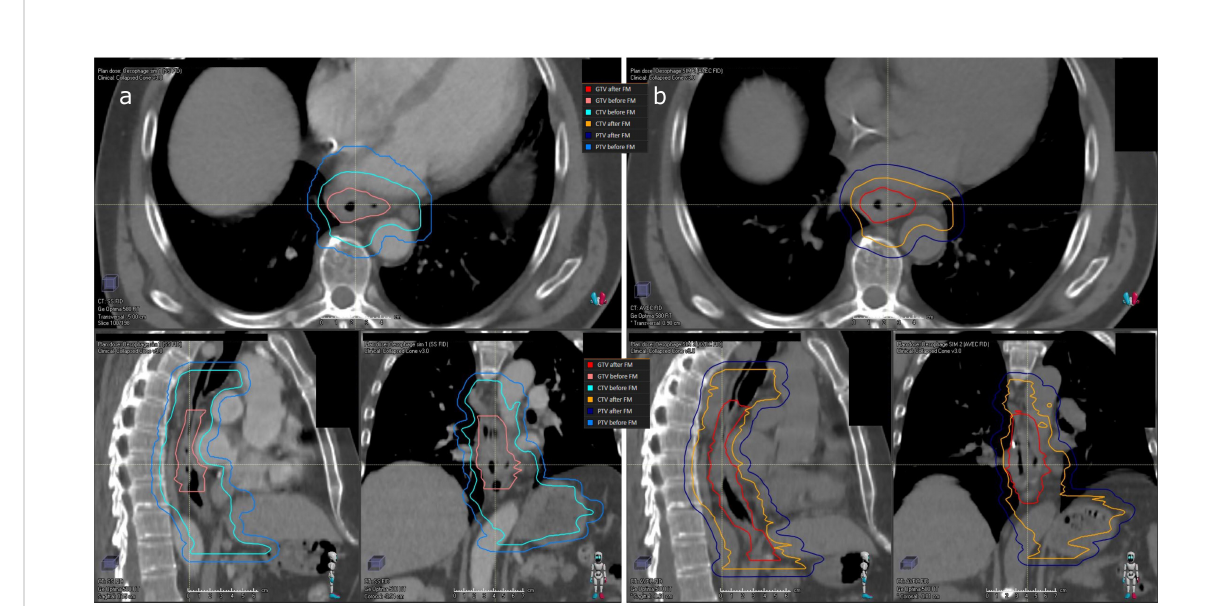
FIGURE 1 Delineation of target volumes before and after fi ducial markers placement for patient n°10. (A) on CT1: GTV (pink line) CTV1 (light blue line) PTV1 (medium blue line); (B) on CT2: GTV (red line) CTV1 (orange line) PTV1 (dark blue